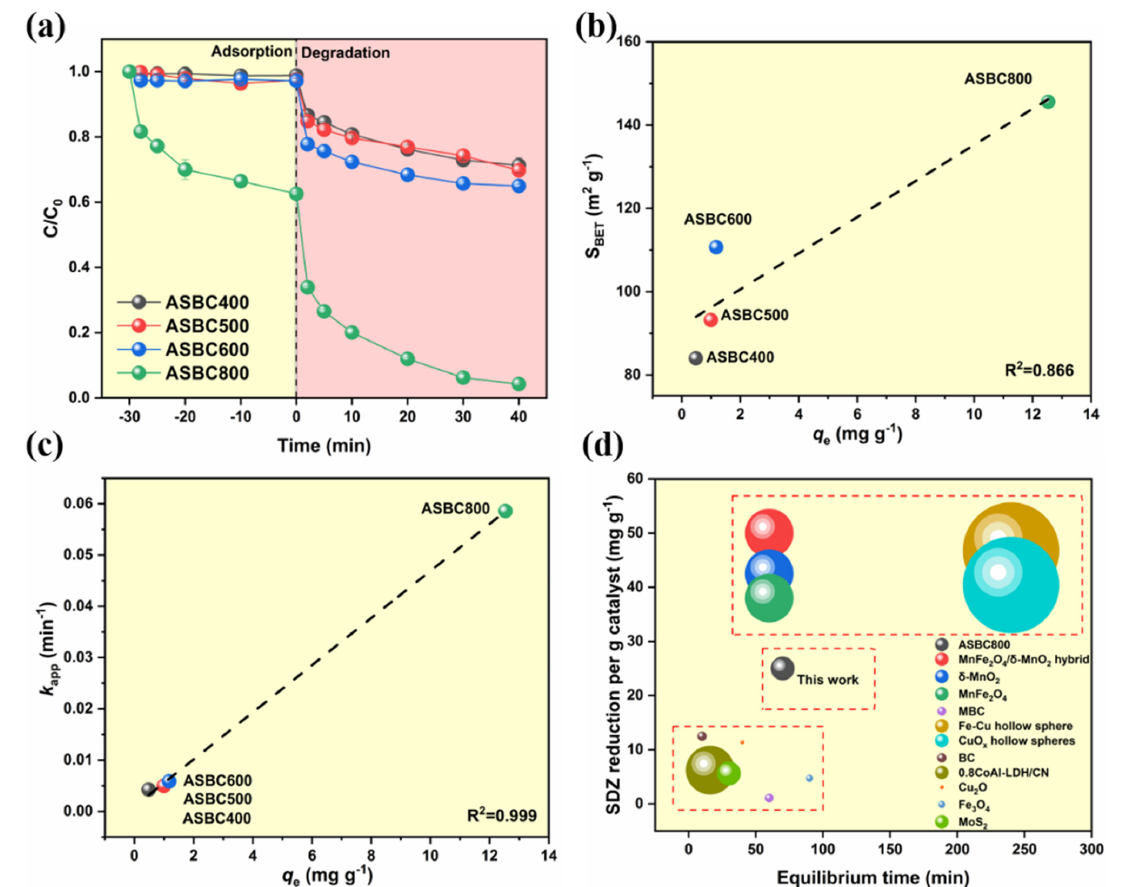
Figure 6. SDZ elimination in the PMS/ASBCx system ( a ), the correlation between S BET and q e ( b ), the correlation between k app and q e ( c ), and the comparisons between the ASBC800/PMS system and other PMS-based oxidation processes for SDZ removal ( d ). (The diameters of the balls were the ratios of PMS/SDZ).